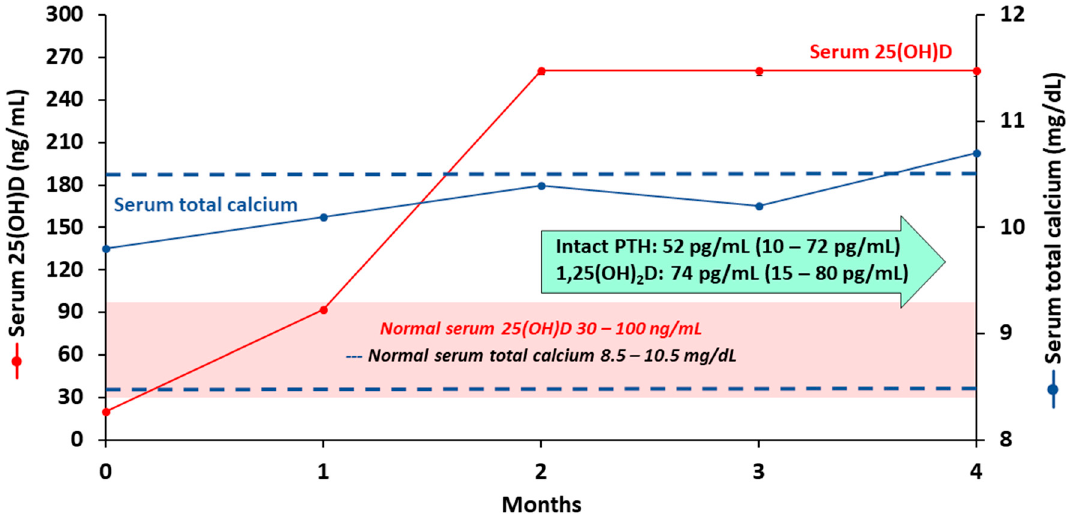
Figure 4. Biochemical measurements of a 32-year-old multiple sclerosis male who received 54,000 international units per day of vitamin D 3 for 4 months. Abbreviation: 1,25(OH) 2 D: 1,25-